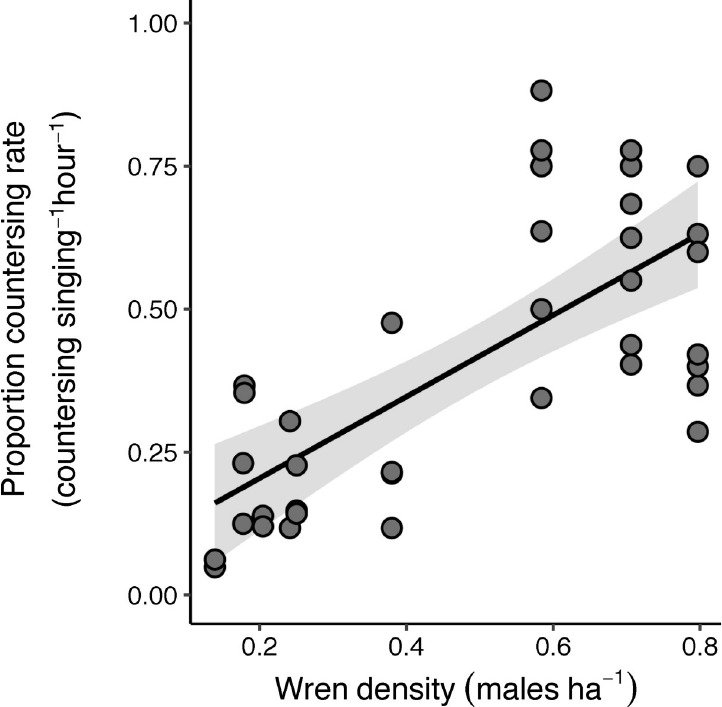
Fig 4. Relationship between absolute male wren density at each stream site and the individual male wren proportional rate of countersinging (countersinging divided by total singing bouts per hour). Wren density was the main predictor variable for the model. The solid line represents the best-fit line from the top model linear regression for proportional countersinging rate and the band represents the 95% confidence interval.